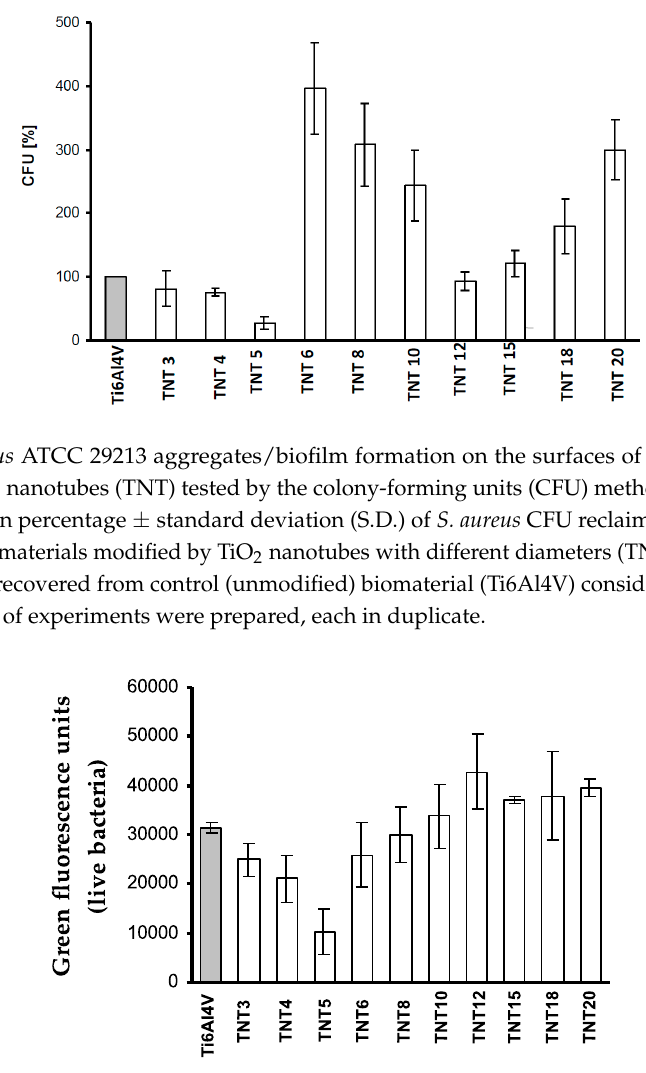
Figure 7. Number of live microorganisms adhered to Ti6Al4V alloy and TNT coatings, obtained in the anodic oxidation of Ti6Al4V surface.